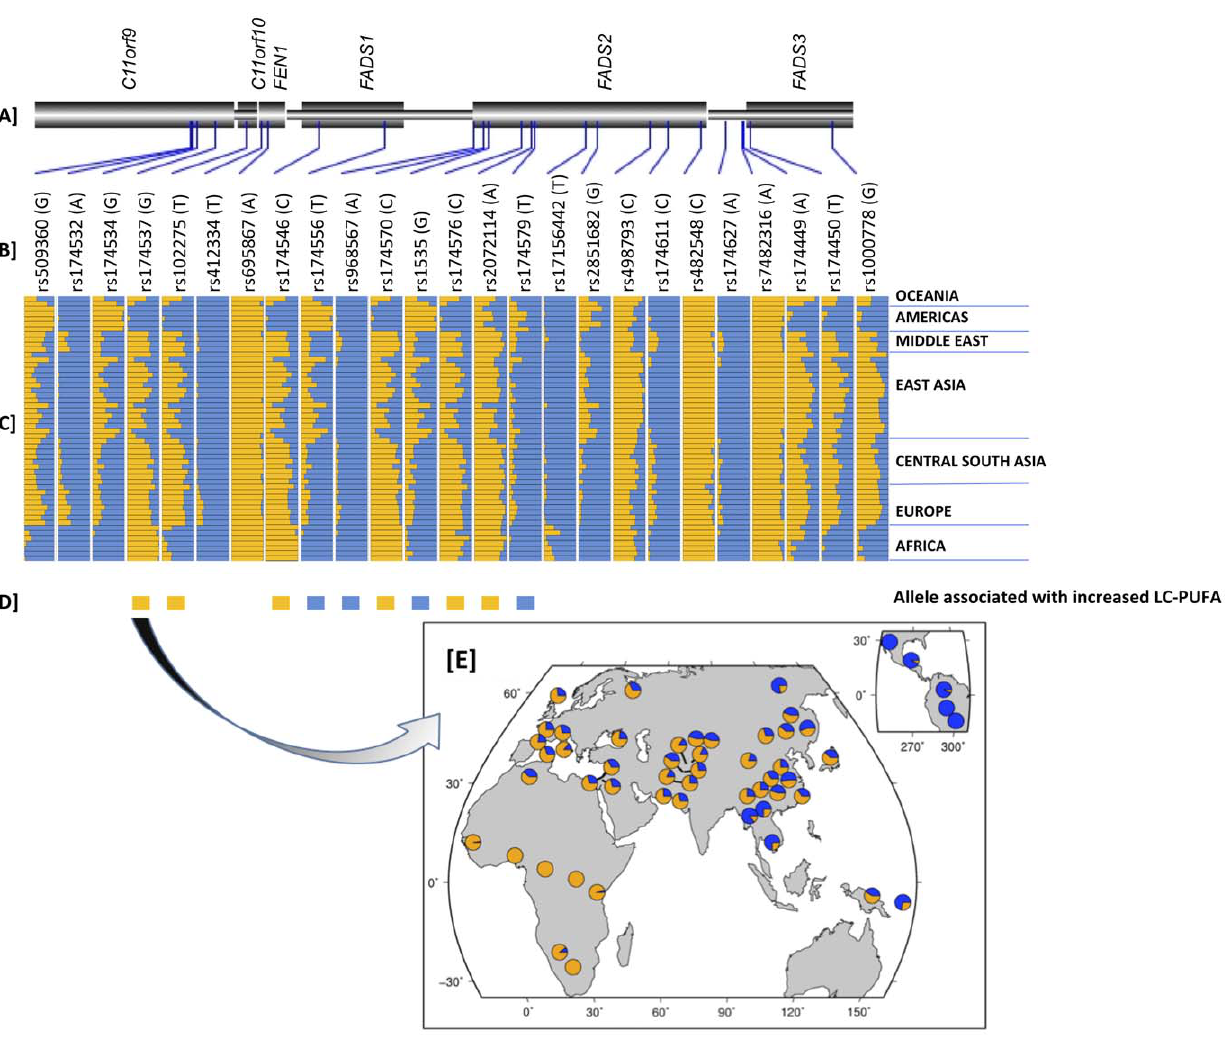
Figure 3. Geographic distribution of derived allele frequencies in a 100 kb region surrounding rs174537 in the 52 populations represented in the Human Genome Diversity Panel Data. Panel A represents physical position of the SNPs relative to genes in the region, Panel B is SNP name (derived allele), Panel C is frequency of derived allele (in orange) in the populations clustered based on geography, Panel D is an indication of the allele associated with increased LC-PUFA metabolism in published association studies, and Panel E is the detailed overview of rs174537 showing is near fixation within Africa.